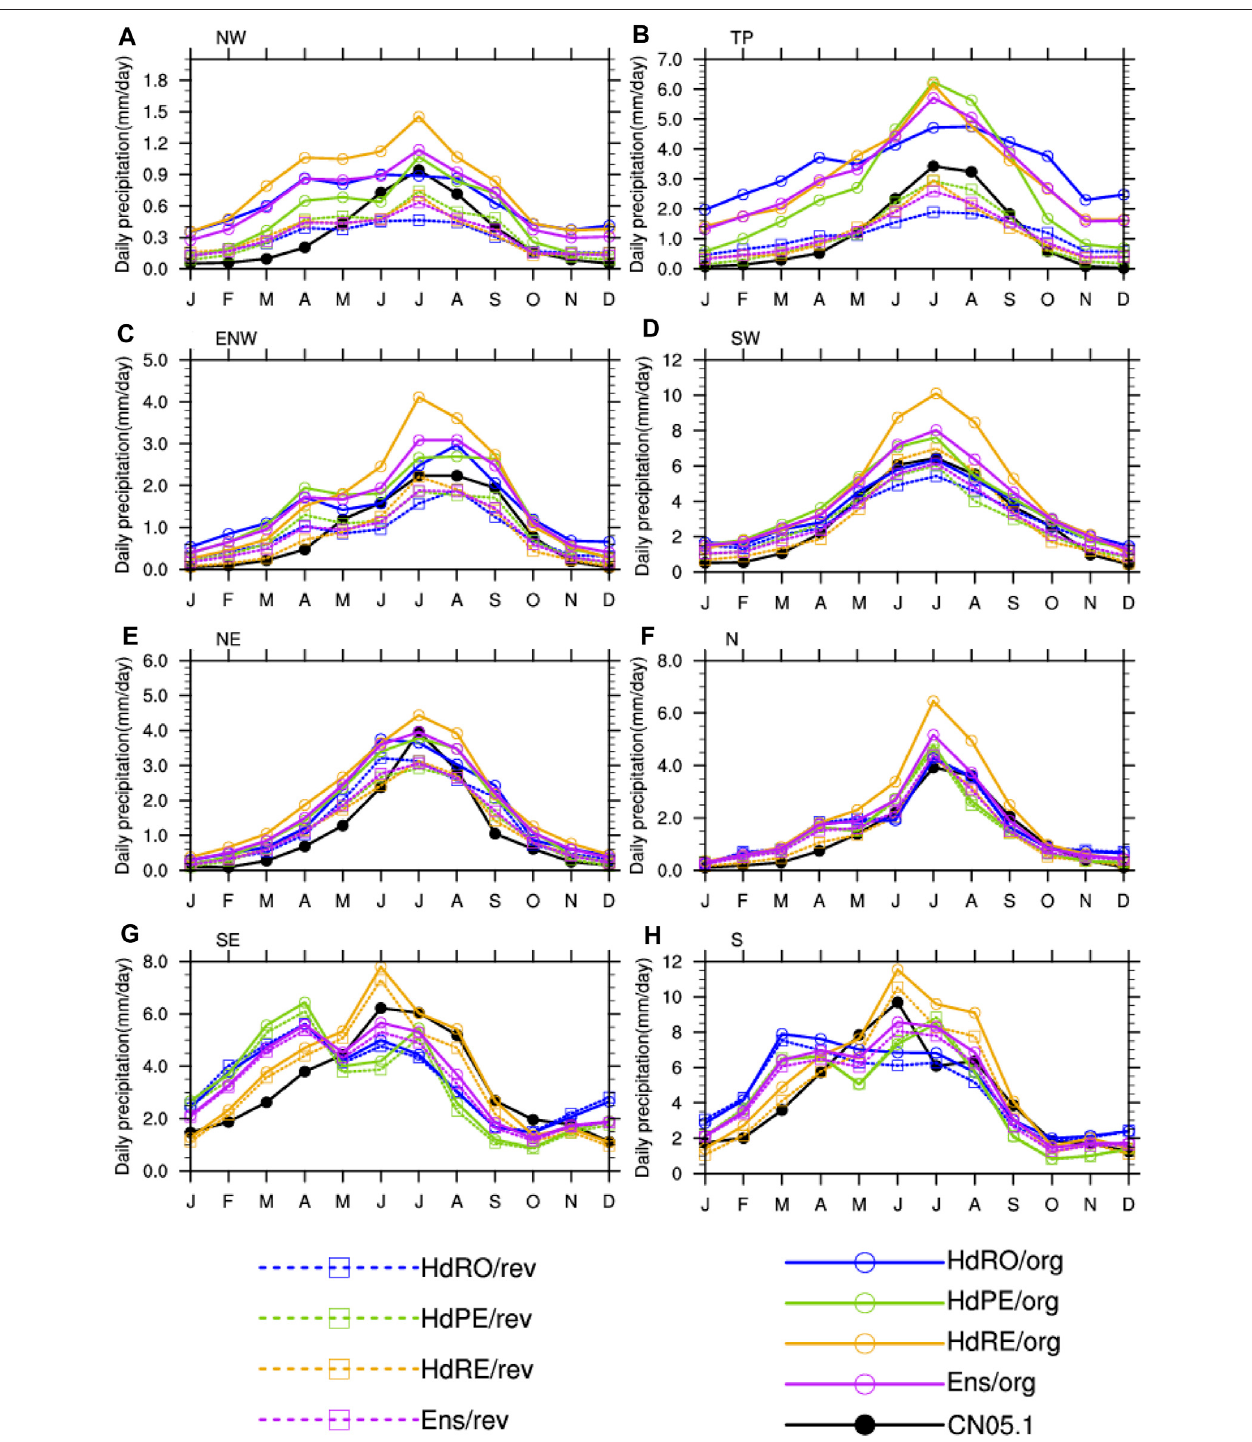
FIGURE 2 | Seasonal cycle of monthly precipitation for the simulations and observations in eight sub-regions (A – H) . The dashed lines with a box indicate the corrected simulations, and the solid lines with a circle denote the simulations before correction. The X-axes are the months, and the Y-axes represent the precipitation